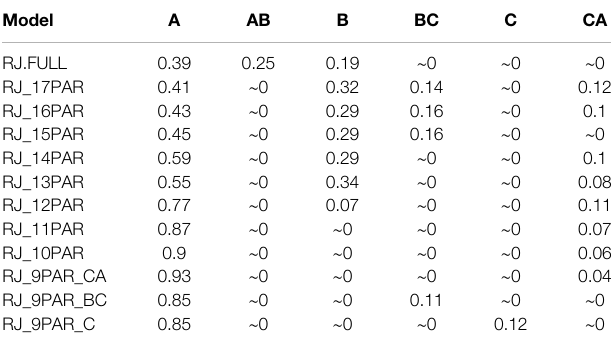
TABLE 2 | Probability of ancestral state estimation of Proto-Indo-European being each of the six states. ∼ 0 are probabilities below 0.05.